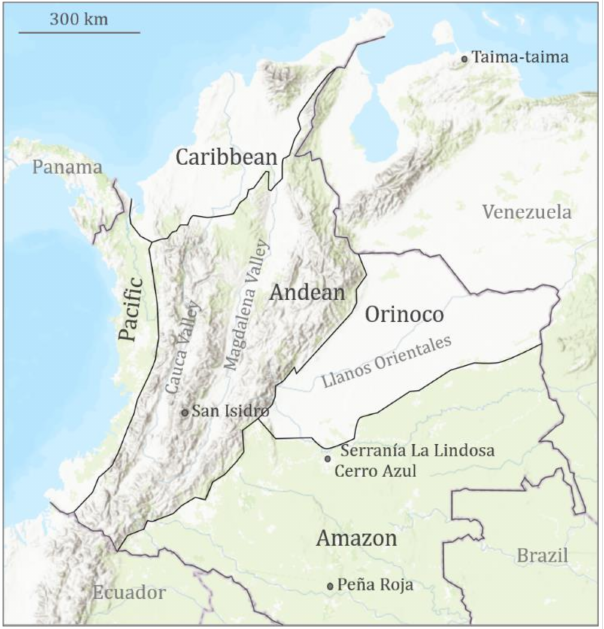
Figure 1. Map showing the location of key sites mentioned in the text and the five biogeographic zones of Colombia: Caribbean, Pacific, Andean, Orinoco, and